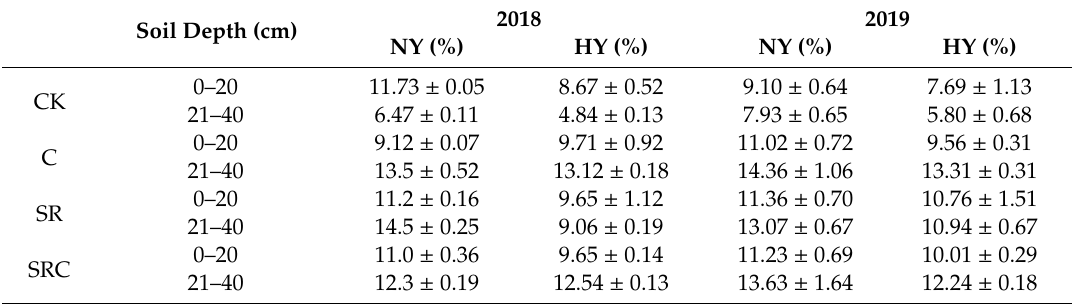
Table 4. E ff ects of biochar and soft rock treatments on soil water content under two fertilizer